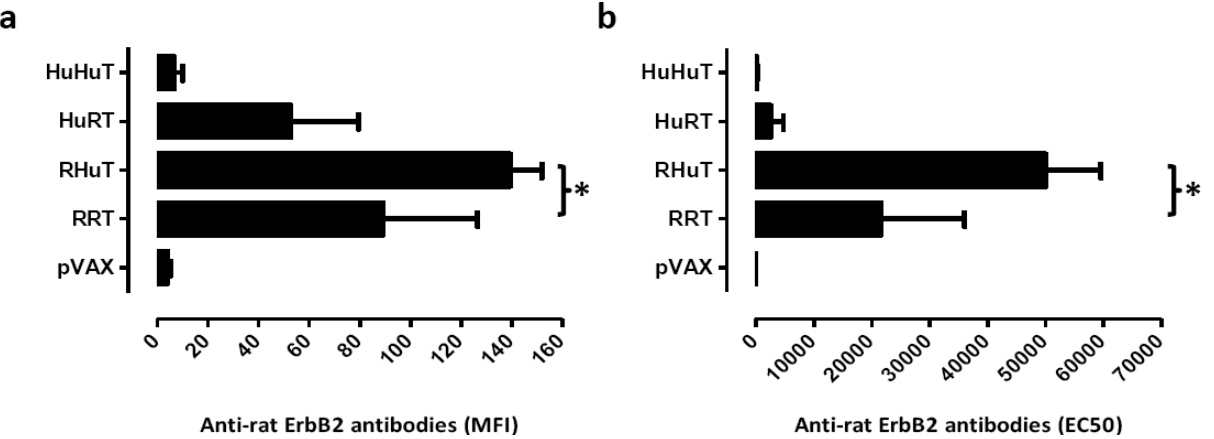
Figure 3. Antibody response against rat ErbB2 protein two weeks after vaccination of BALB/c mice with pVAX, RRT, RHuT, HuRT and HuHuT. The anti-rat ErbB2 antibody titre was evaluated both by flow cytometry (a) and by ELISA (b). (a) Sera were incubated with rat ErbB2 + and rat ErbB2 − fibroblasts and anti-mouse IgG antibodies as previously described [21]. Data are reported as Mean Fluorescence Intensity (mean MFI ± SEM). *, p = 0,02, Student’s t test; (b) The anti-rat ErbB2 antibody titre was detected by indirect ELISA and is expressed as EC50 (mean EC50 ± SEM) *, p = 0,03, Student’s t test. Rat ErbB2 protein (0.1 µ g/well in PBS pH 7.4) was incubated at 4 °C overnight, and then washed two times with PBS plus 0.05% Tween 20 (PBST). Antigen coated wells were blocked using 1% BSA at 37 °C for 2 hr and washed twice with PBST. Serum samples were added, and the plate was incubated at 37 °C for 2 hr, washed two times with PBST and supplemented with goat-anti mouse IgG HRP conjugate in PBST-BSA. After 90 min incubation at 37 °C, the wells were washed with PBST and 100 µ L of ready prepared substrate solution (TMB) were added and incubated for 15 min at RT. The reaction was stopped and the absorbance was measured at a wavelength of 450